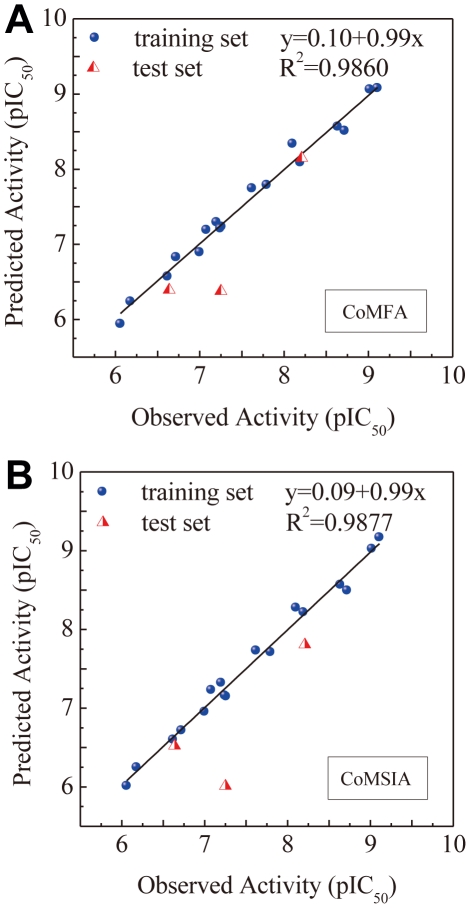
Correlation of observed and predicted activity (pIC50) using 3D-QSAR models.(A) CoMFA and (B) CoMSIA.